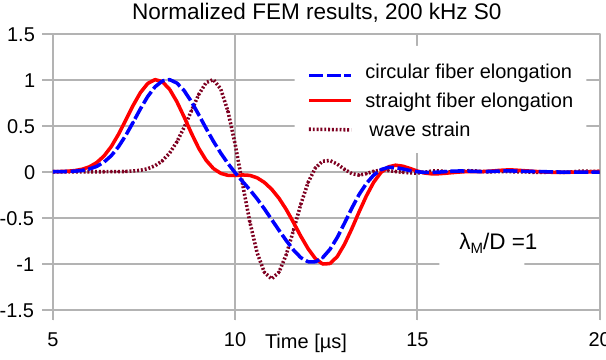
Figure 9. Time dependence of plane wave strain and circular/straight transducer output signals for λ M = D